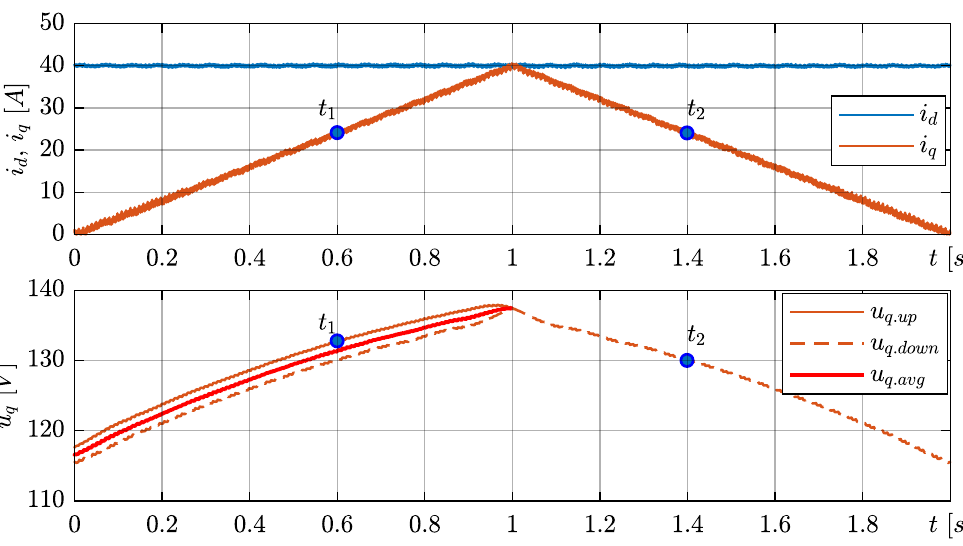
Figure 2. Voltage averaging for current derivative